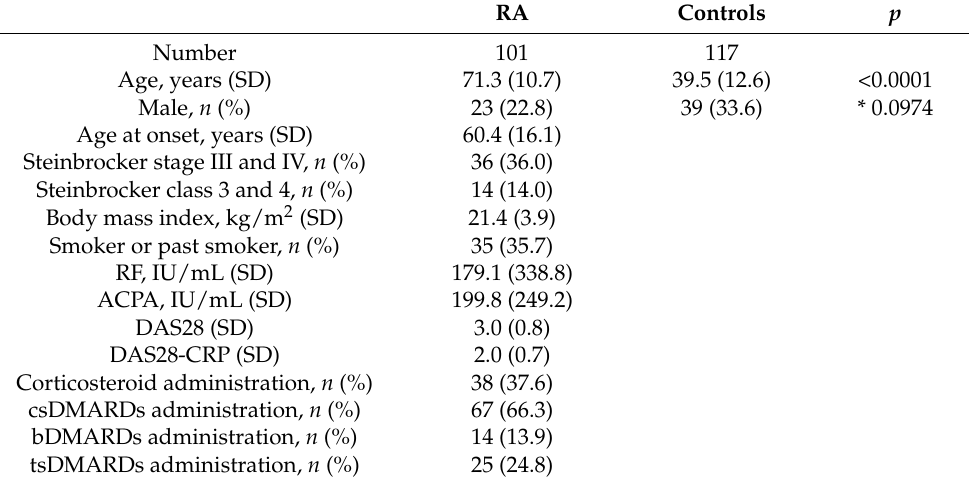
Table 1. Characteristics of RA patients and